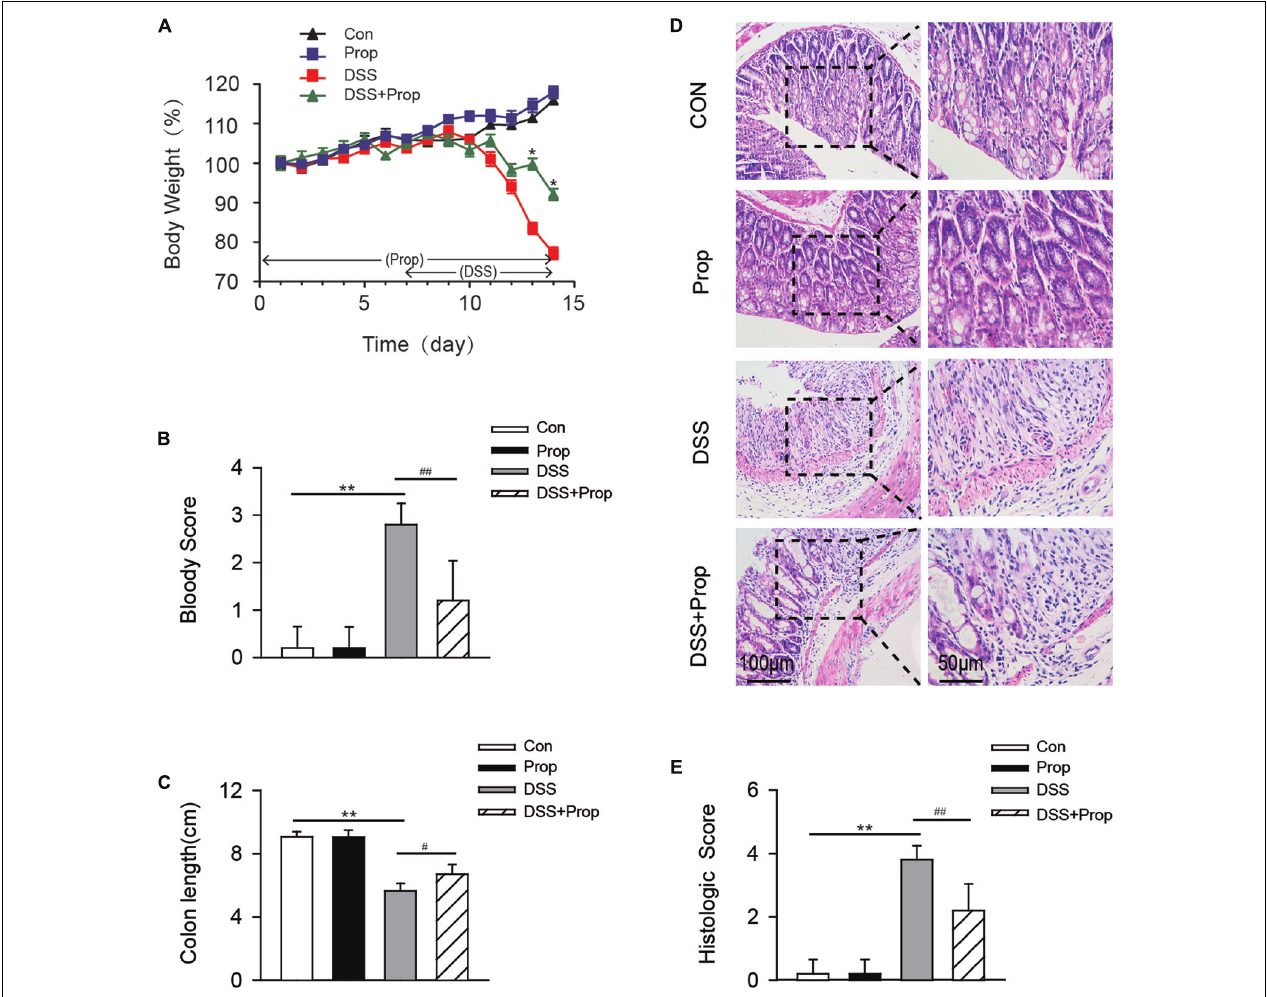
FIGURE 1 | Effects of sodium propionate on body weight, bloody score, colon length, and histopathology in DSS-induced colitis mice. Mice were divided into four groups. Animals in control and propionate groups received water and sodium propionate [1% (w/v) dissolved in water] alone, respectively, during the 14-day treatment period. Animals in DSS group received drinking water from 1 to 6 days and DSS [3% (w/v) dissolved in double distilled water] instead of drinking water from 7 to 14 days. Animals in DSS + propionate (DSS + Prop) group were given 1% sodium propionate for 14 consecutive days and supplemented with 3% DSS solution on day 7–14. Body weight (A) , bloody score (B) , and colon length (C) were examined. HE stained colon tissue sections were analyzed for histopathology (D) . Images were representative of 6–8 mice. Colon injury scores were also determined (E) . Scar bars were 100 and 50 µ m, respectively. Data are presented as mean ± SD, n = 10 per group. ∗ P < 0.05, ∗∗ P < 0.01 vs. control group; # P < 0.05, ## P < 0.01 vs. DSS